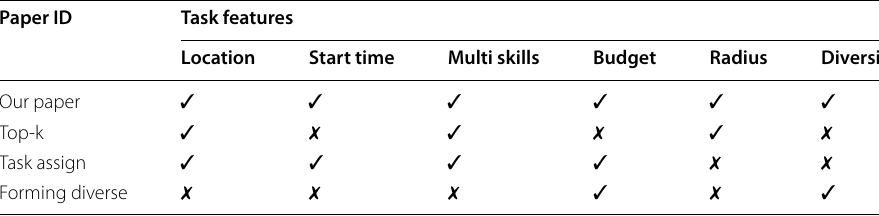
Table 1 Comparison of task between our paper and other papers Paper